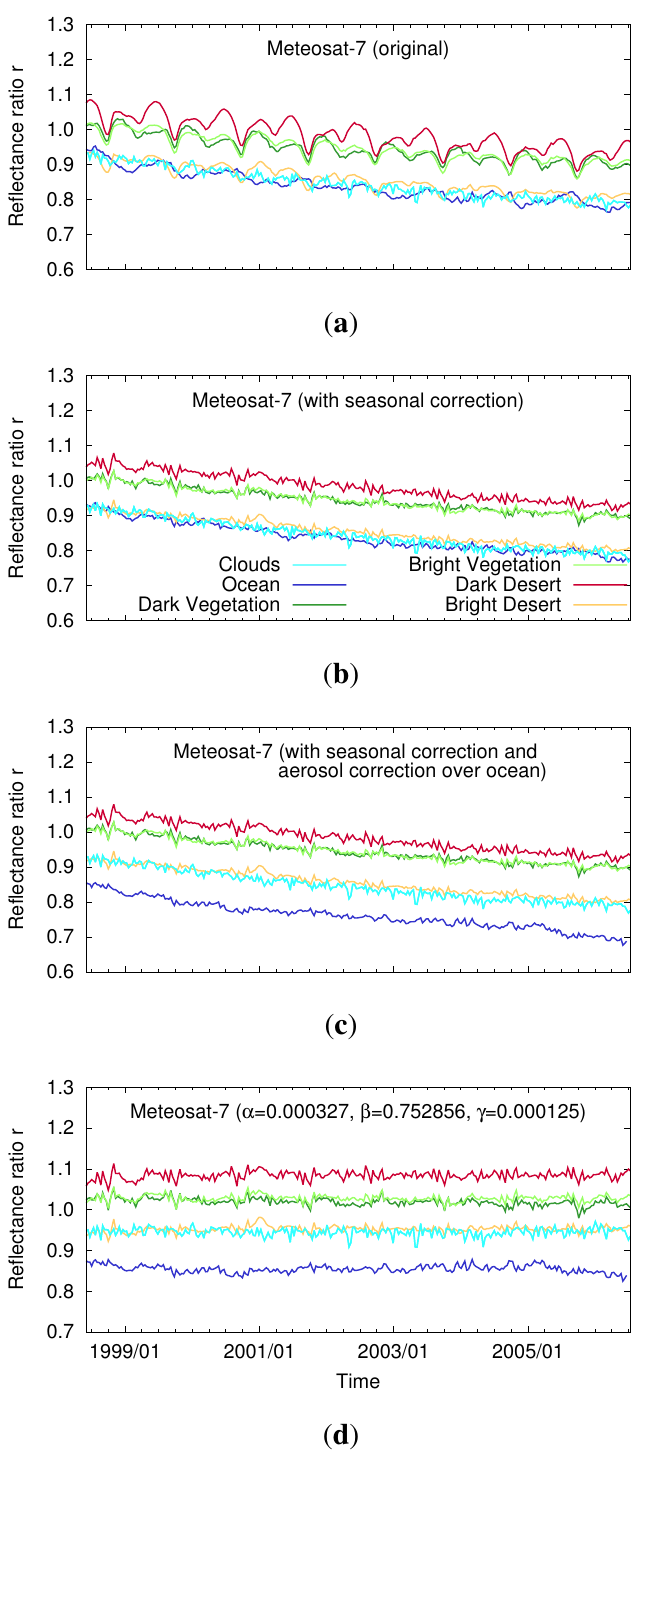
Figure 16. Meteosat-7 time series ( a ) original; ( b ) after seasonal correction; ( c ) after aerosol correction; and ( d ) after ageing